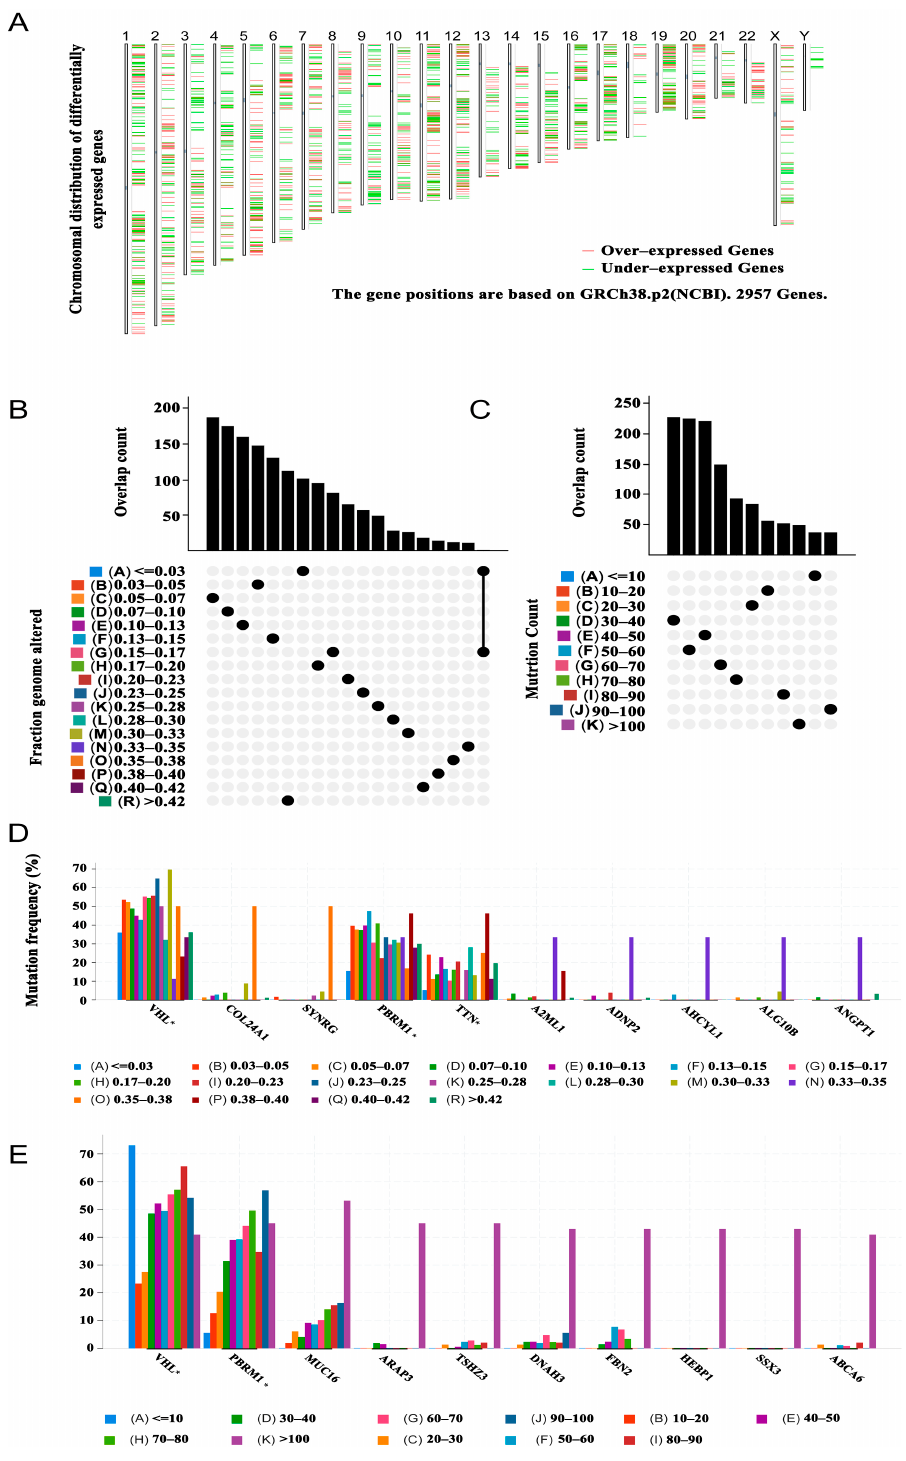
Figure 1. Potential tumour antigens of KIRC were identified from the database. ( A ) Chromosomal distribution of potential tumour-associated antigens in KIRC, with upregulation and downregulation indicated in red and green, respectively. ( B ) Summary of the distribution of mutant genes in the fraction-genome-altered group. ( C ) Summary of the distribution of mutant genes in the mutation-counting group. The highest frequency genes in altered genome fraction groups ( D ) and mutation count groups. ( E ) Kidney renal clear cell carcinoma (KIRC).